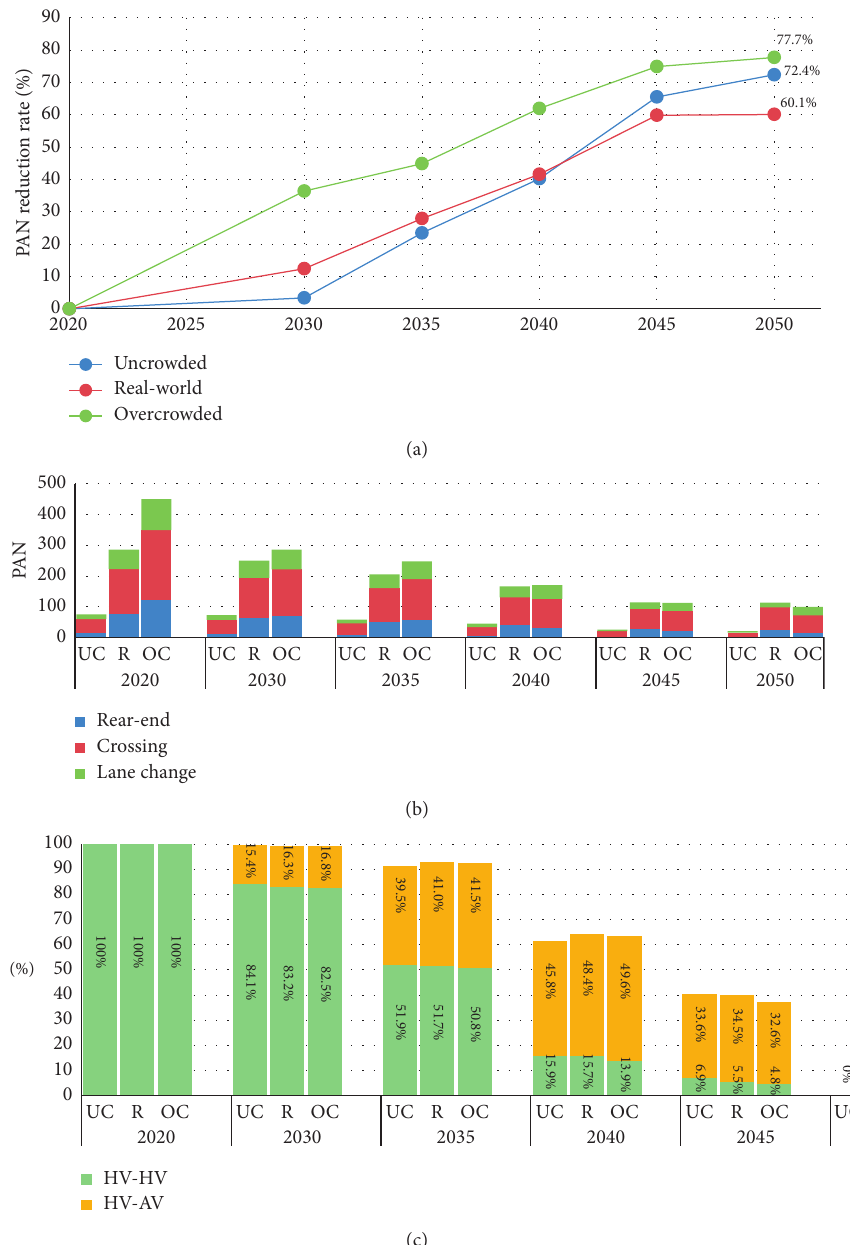
Figure 8: Detailed results of PAN at Vesal intersection for each demand scenario (UC: uncrowded, R: real-world, OC: overcrowded). (a) Potential accident number reduction rate. (b) PAN segregated by conflict type. (c) Percentage of PAN involving